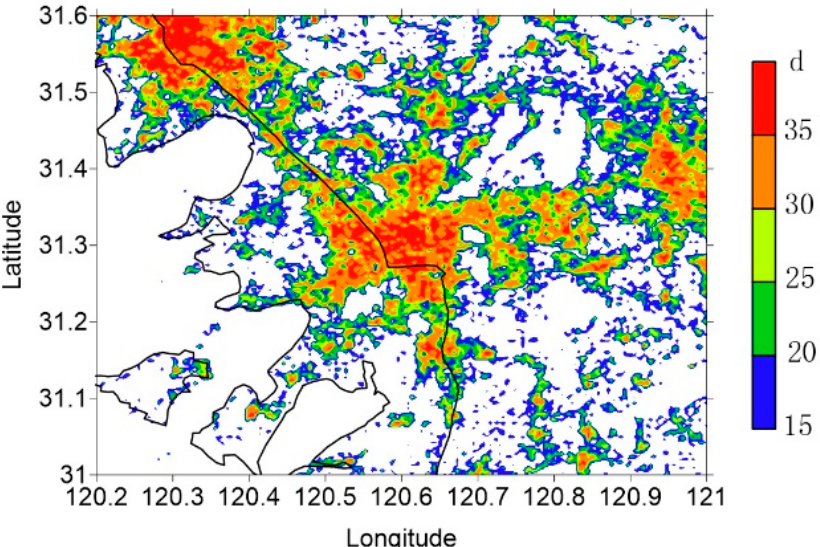
Figure 9. Same as Figure 2 but for annual average high-temperature day numbers.